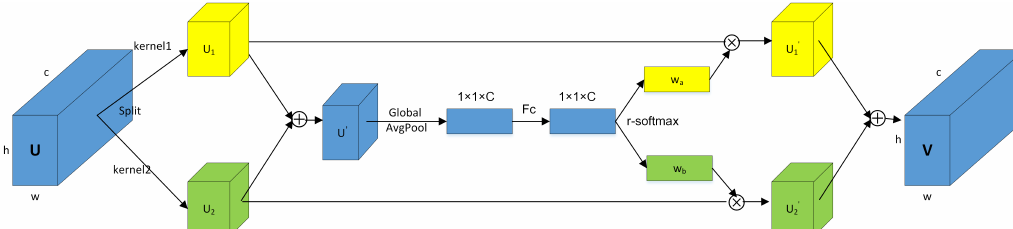
Figure 3. Illustration of the proposed in-channel attention block. Several channels are obtained by convolution, then calculate the weights of every channel and concatenate them